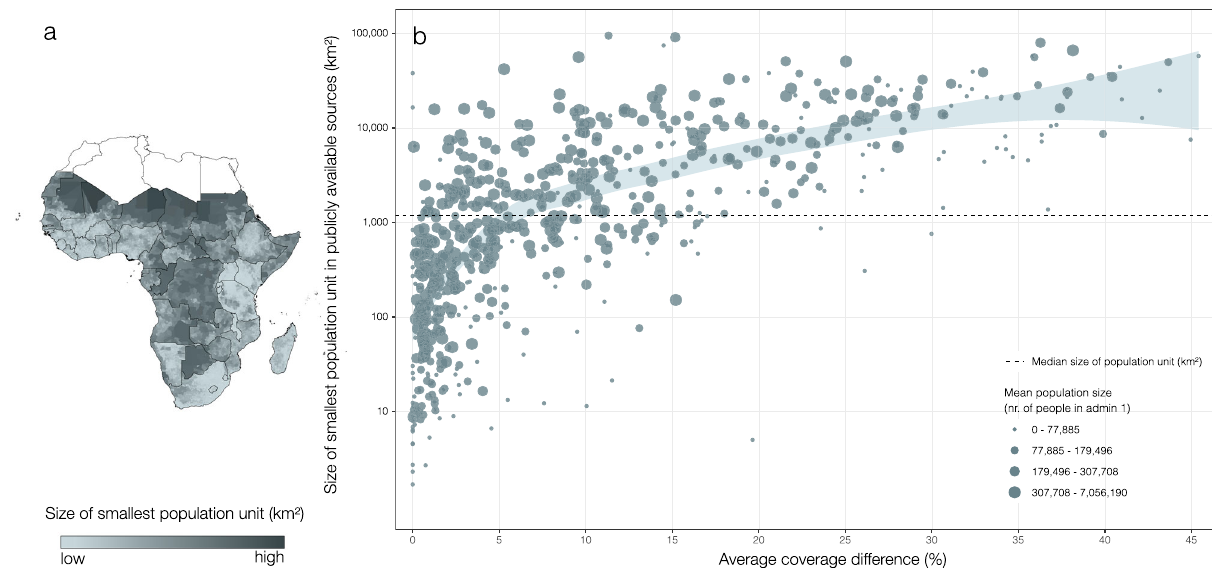
Fig. 7 Association between size of population unit and difference in accessibility coverage. a Spatial variation of the size of the smallest publicly available population unit. b Association between population input unit size and the average relative difference in accessibility coverage between the datasets. The size of the points indicates the total population averaged for all datasets at administrative level